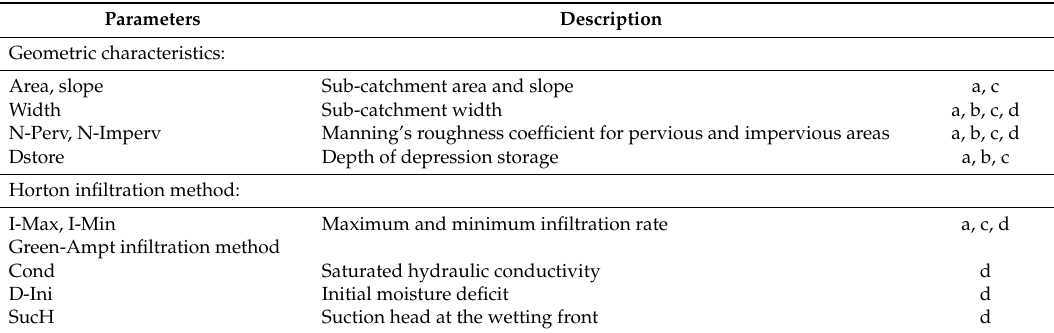
Table 3. Important parameters for the hydrologic components of